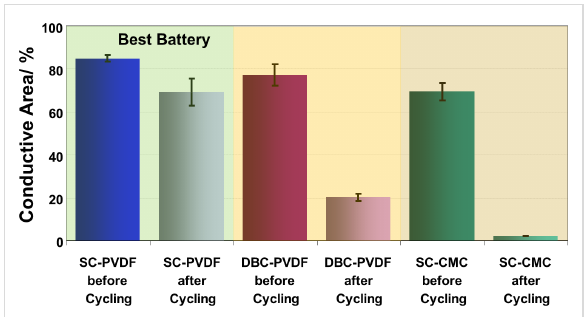
Figure 8: Conductive area during image acquisition under identical conditions at the cathodes before and after 50 cycles; area 3 µm × 3 µm, U = 0.5 V with same AFM